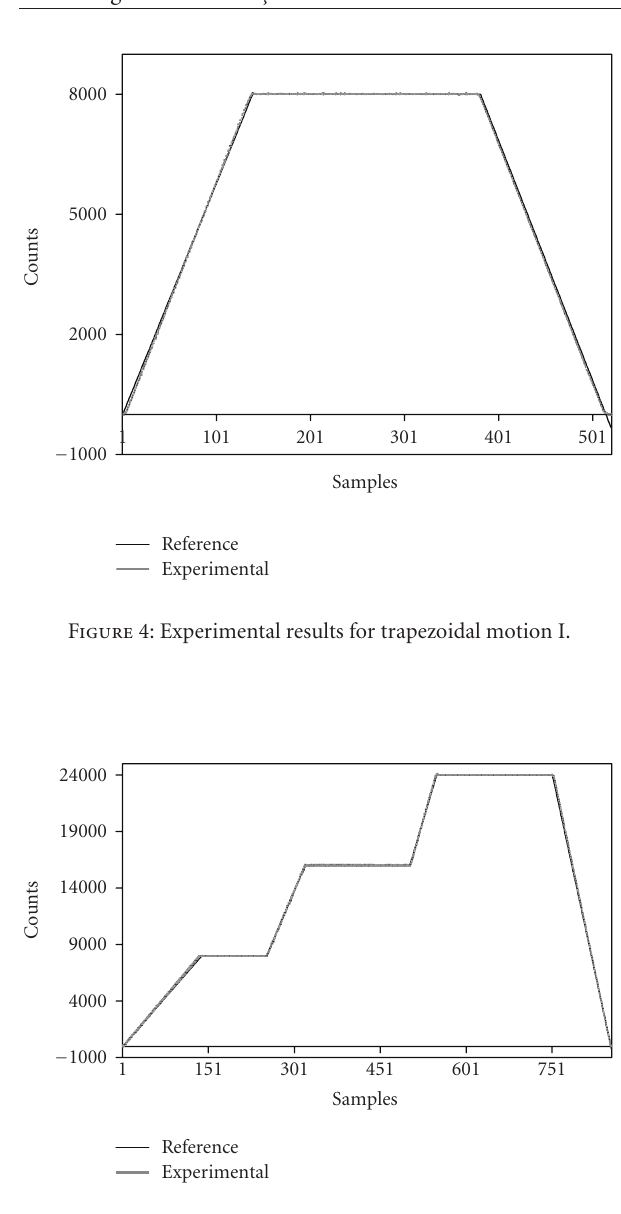
The experimental AC servomotor system is operated un- der loaded and unloaded cases. Figures 4 and 5 represent the experimental results of trapezoidal motion I and II responses when the system is coupled to a fixed load. The variables are scaled as digital counts and number of samples in exper- imental results. Trapezoidal motion I is taken as 520 sam- ples, referring to 4.16 seconds overall. Trapezoidal motion II is taken as 854 samples covering 6.8 seconds all. The output tracks the reference well. Actually, the best tracking perfor- mance is achieved when PID controller gains are tuned. Ex- perimental controller tuning values are found as K p = 20, K V = 12, and K i = 3,